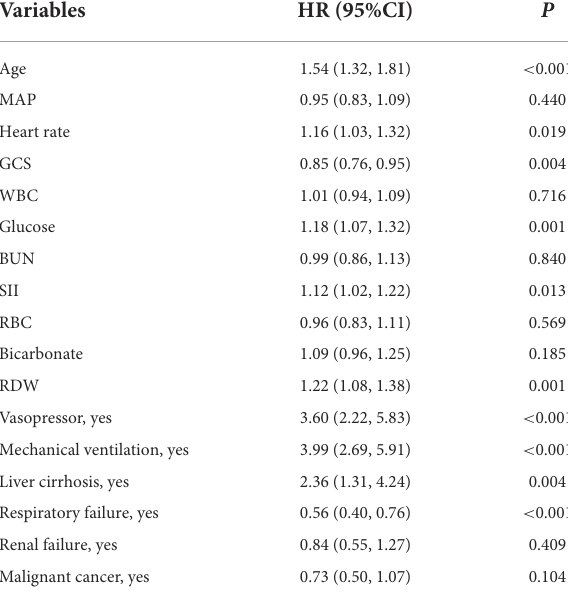
TABLE 2 The HR of the selected predictor in multivariate Cox regression